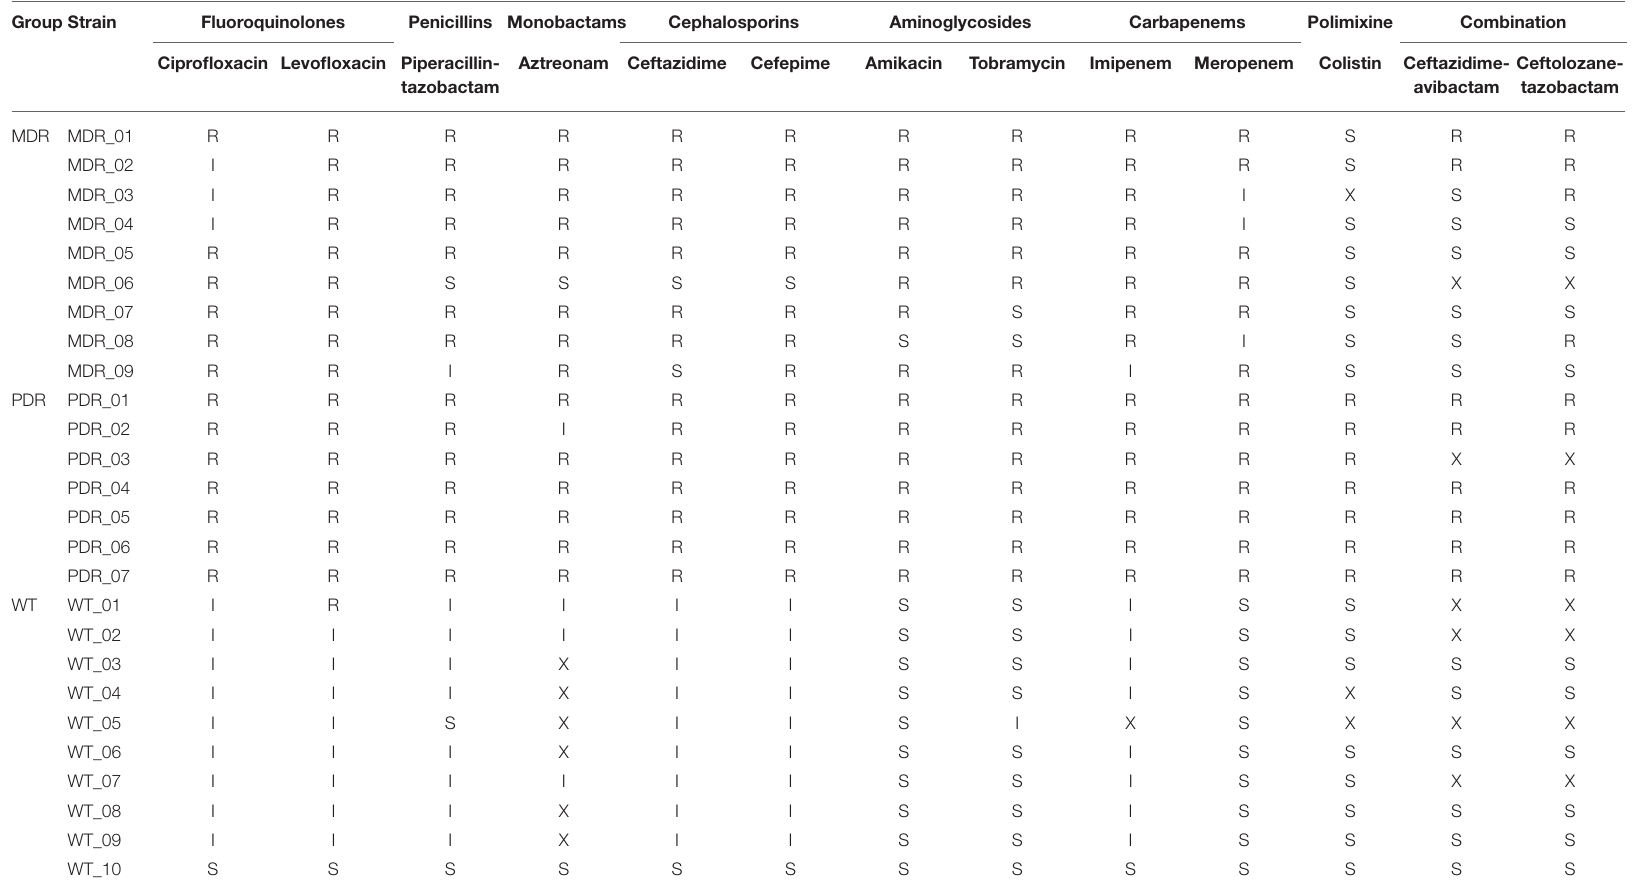
TABLE 1 | List of studied P. aeruginosa strains and their antibiotic susceptibility profiles. Group